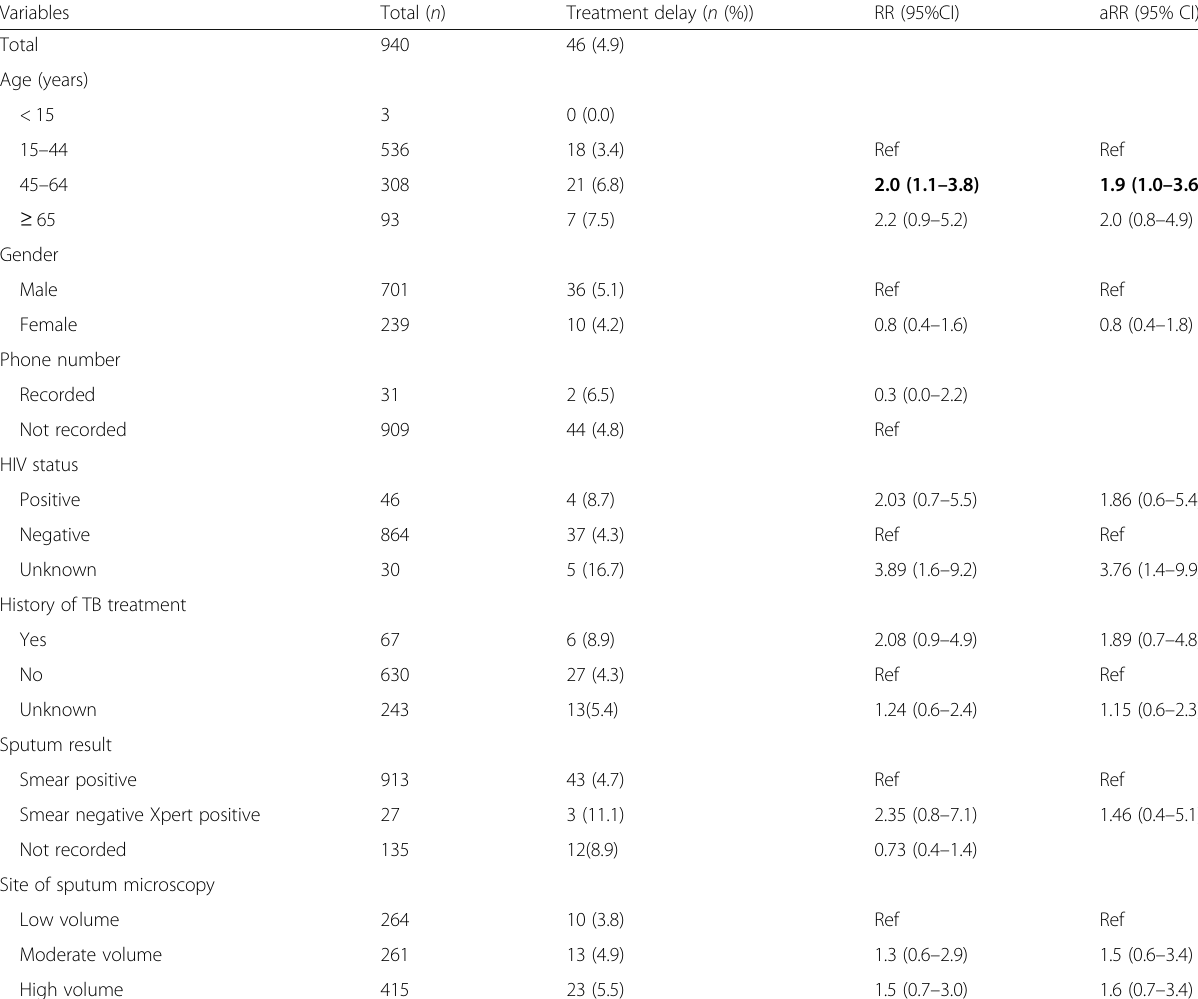
Table 3 Factors associated with treatment delay among bacteriologically confirmed TB patients who received treatment in 21 township health centres of the Mandalay Region of Myanmar between January and June